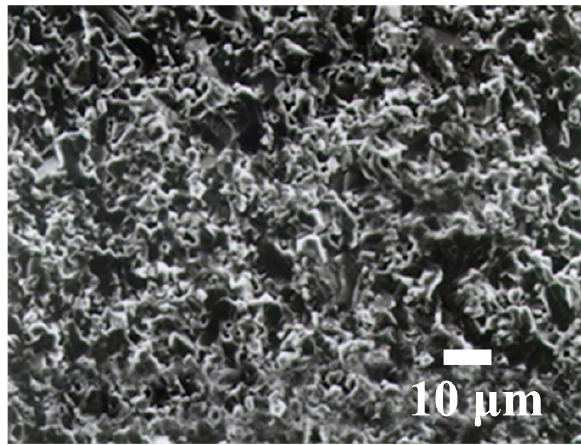
Figure 9. The effect swinging and non-swinging processes on the machined SR for Al 2 O 3 for different slurry concentrations.